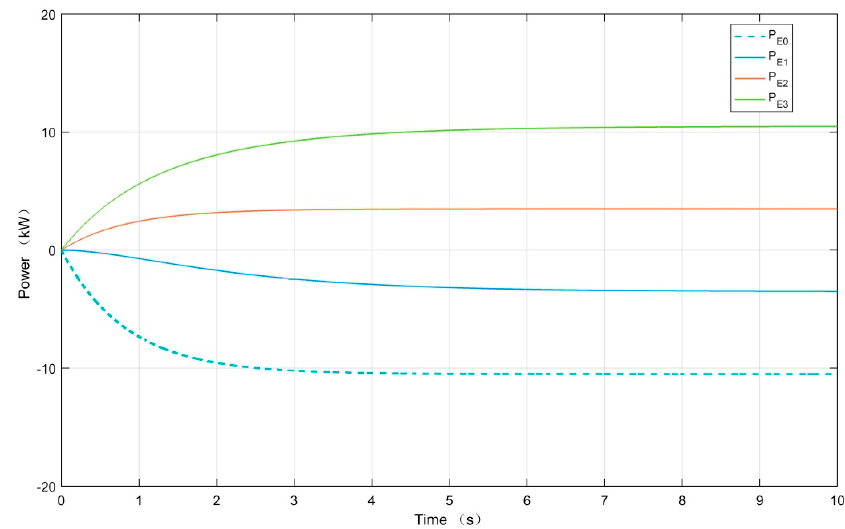
Figure 9. Exchange power of modules.